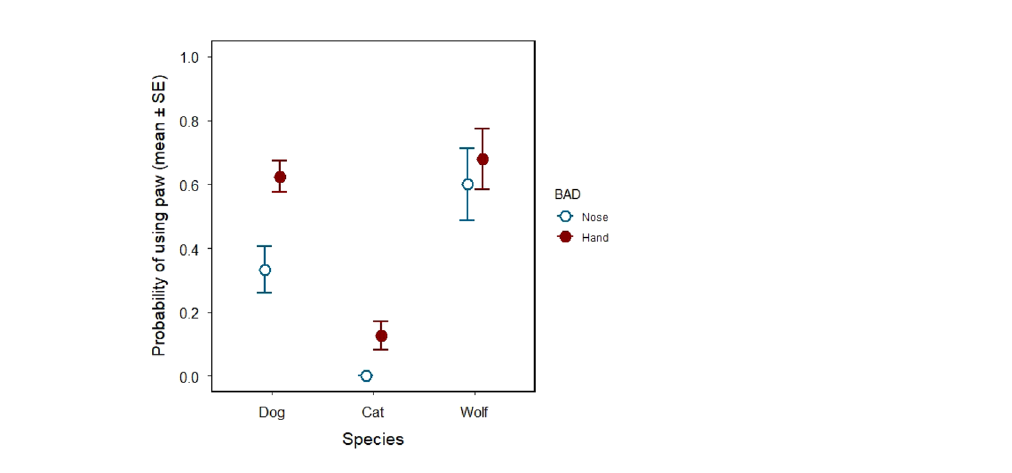
Figure 6. Probability of using paw in dog puppies, kittens and wolf pups, based on the body action of the demonstration (‘BAD’: nose or hand) by the human. Dog puppies used their paw to interact with the